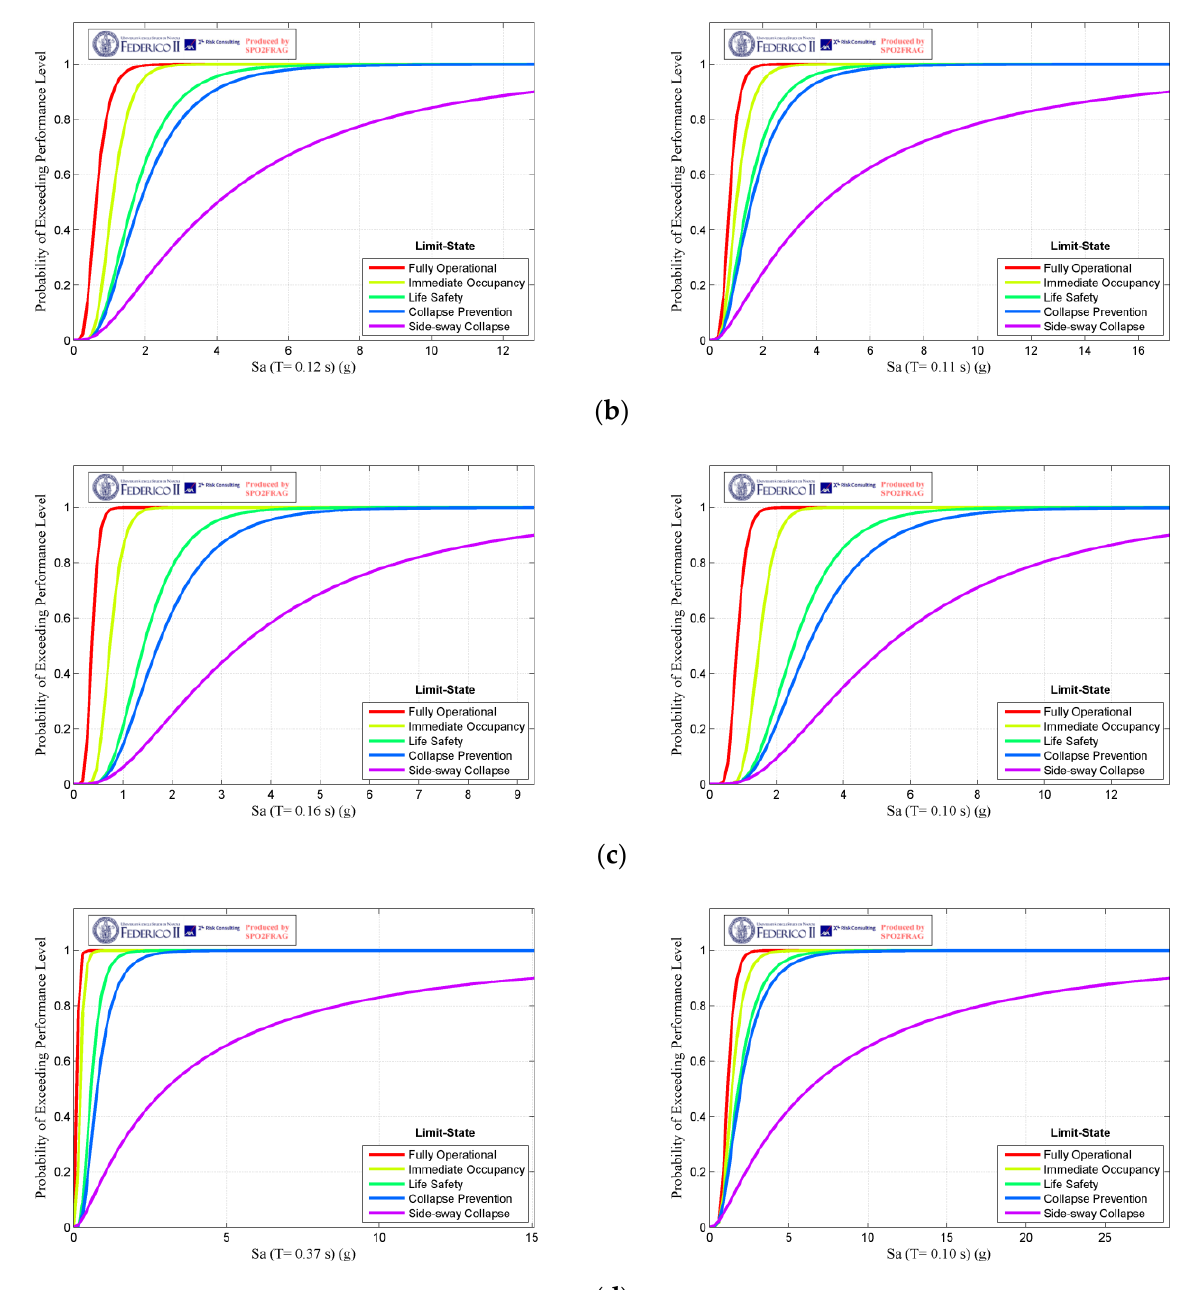
Figure 12. Push-over-based fragility curves of the CM models: ( a ) Type-1; ( b ) Type-2; ( c ) Type-3; ( d ) Type-4.